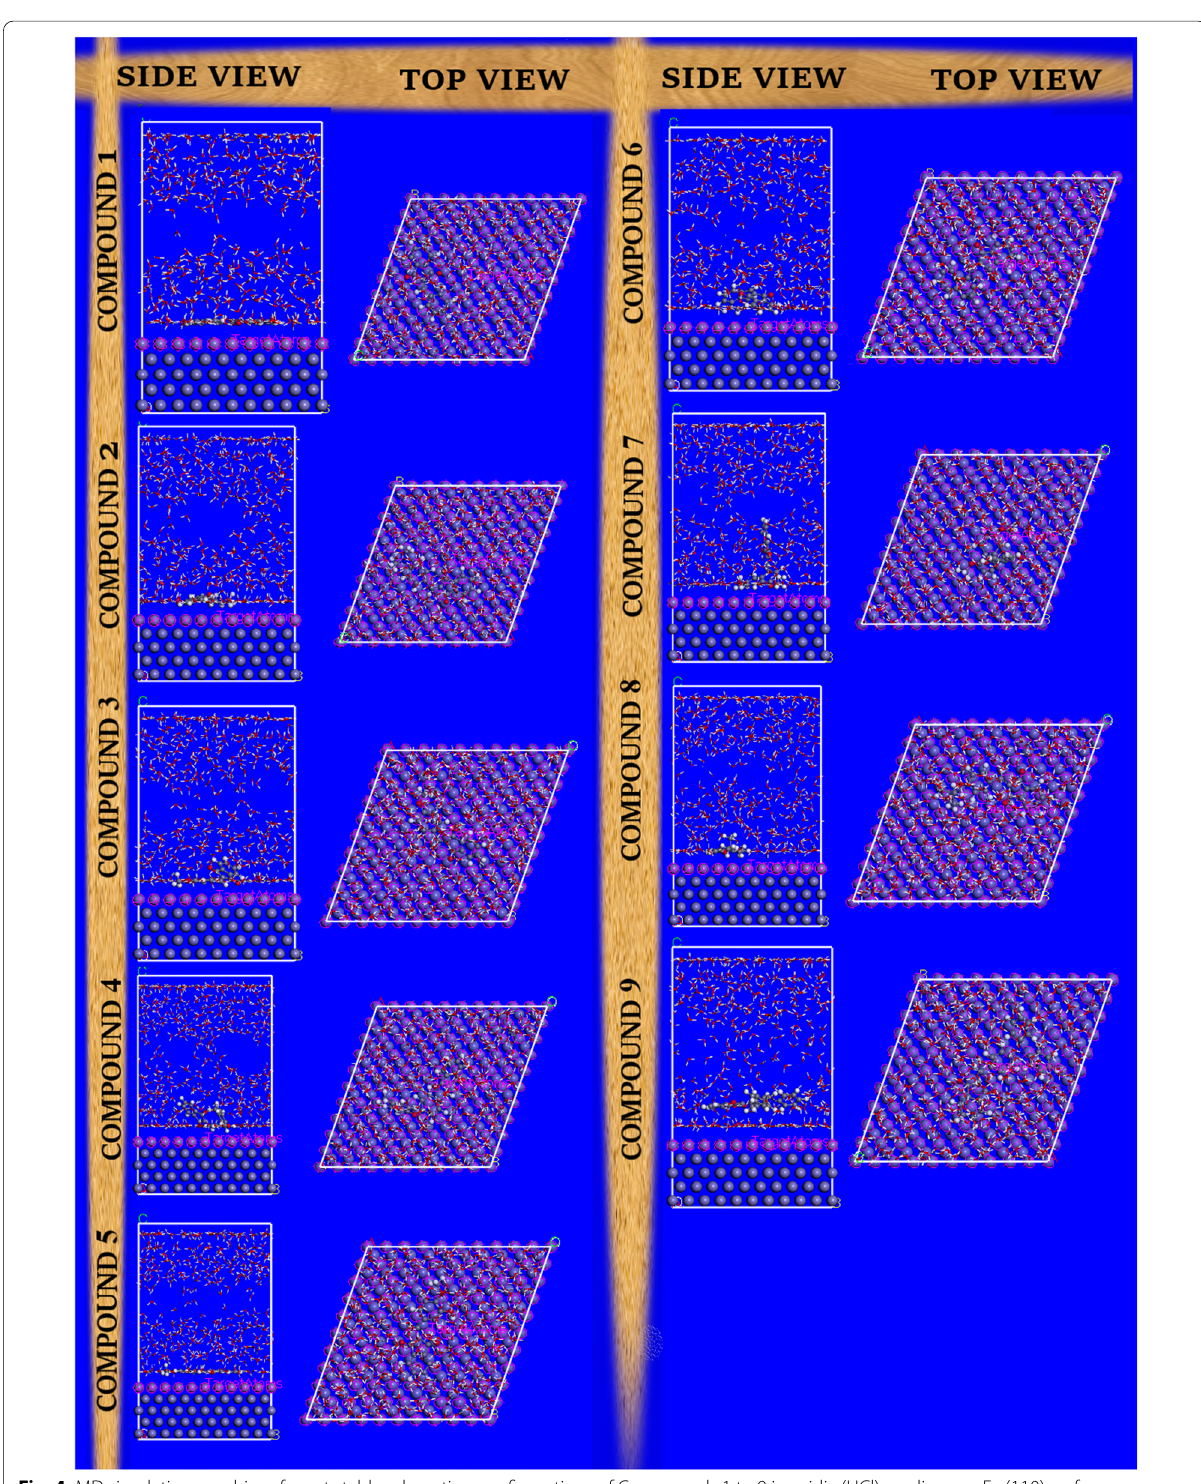
Fig. 4 MD simulation graphics of most stable adsorption configurations of Compounds 1 to 9 in acidic (HCl) medium on Fe (110)